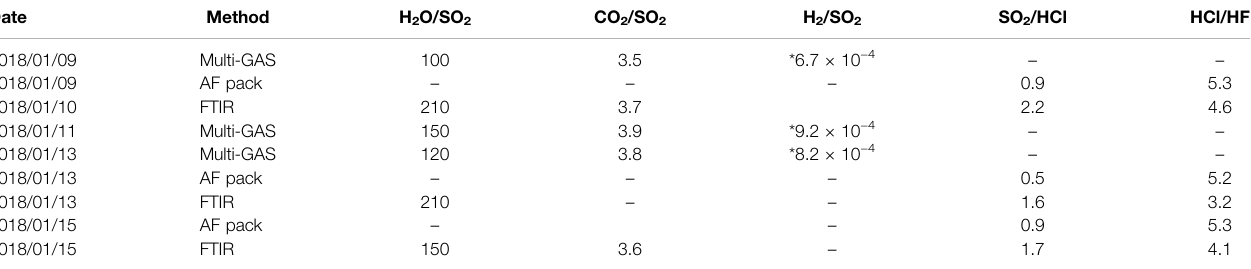
*Values are for reference because of the weak signals and the huge background errors. For details, see text.